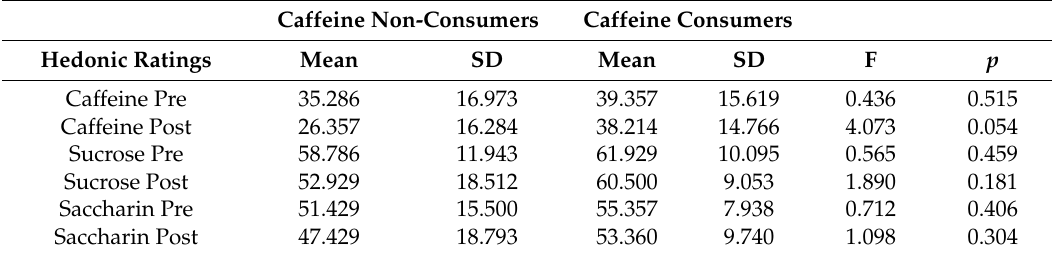
Table 2. Hedonic ratings for caffeine non-consumers and matched caffeine consumers.